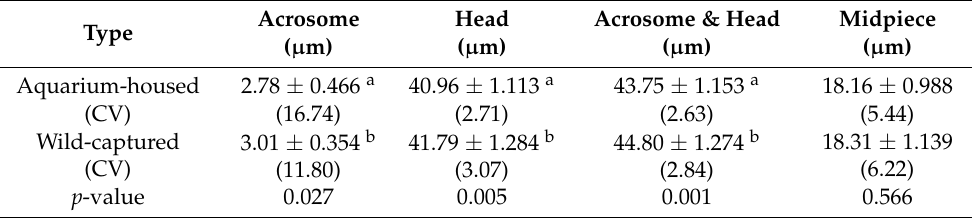
Table 3. Spermatozoa morphometric comparison for aquarium-housed and wild-captured small- spotted catshark ( Scyliorhinus canicula ). Data are expressed as the mean ± standard deviation and coefficient of variation (CV, %).